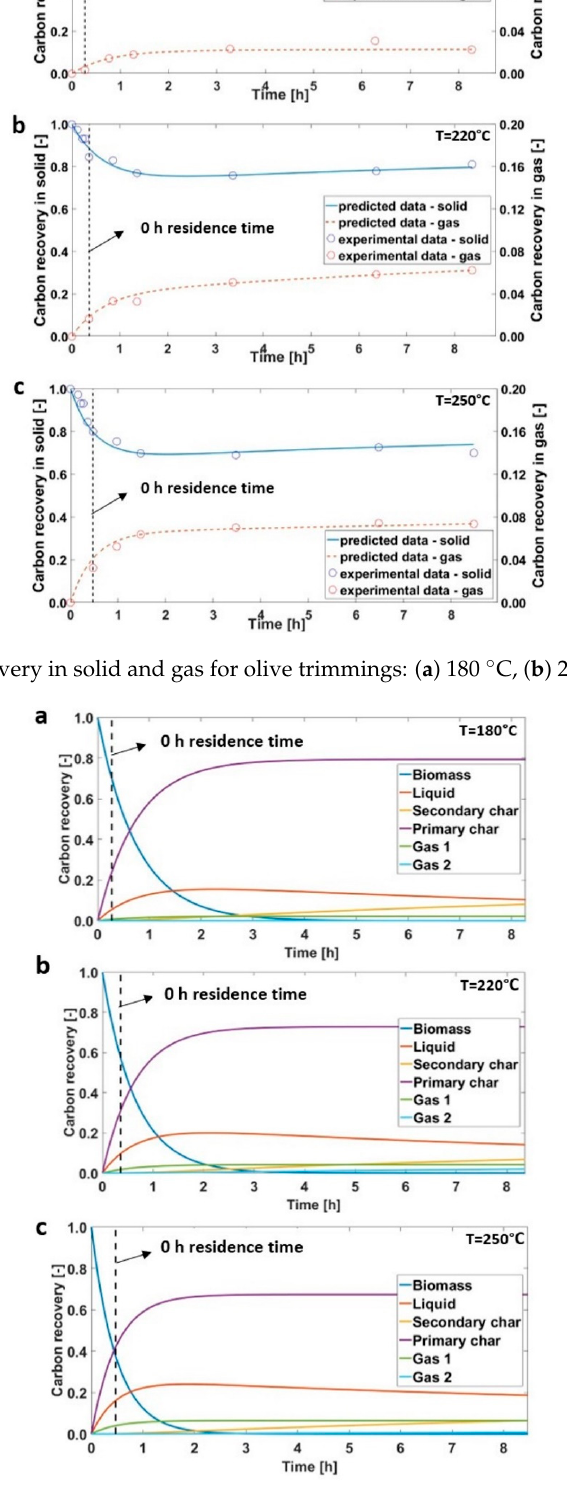
Figure 5. Carbon recovery (-) into HTC products versus residence time (h) for olive trimmings: ( a ) 180 °C, ( b ) 220 °C, and ( c ) 250 °C.